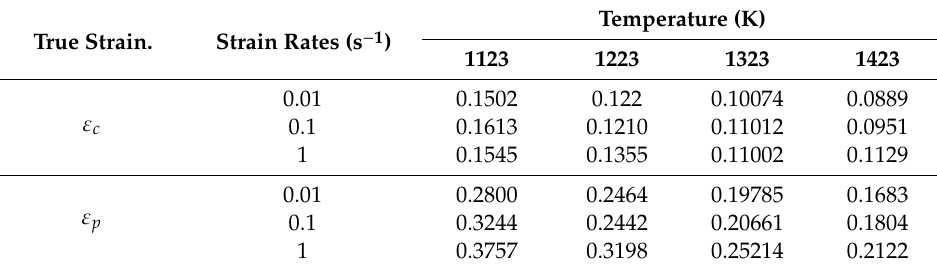
Figure 5. The hardening rate curves under different strain rates ( a ) Table 3. Values of ε c and ε p at di ff erent deformation conditions. True Strain. Strain Rates (s − 1 )